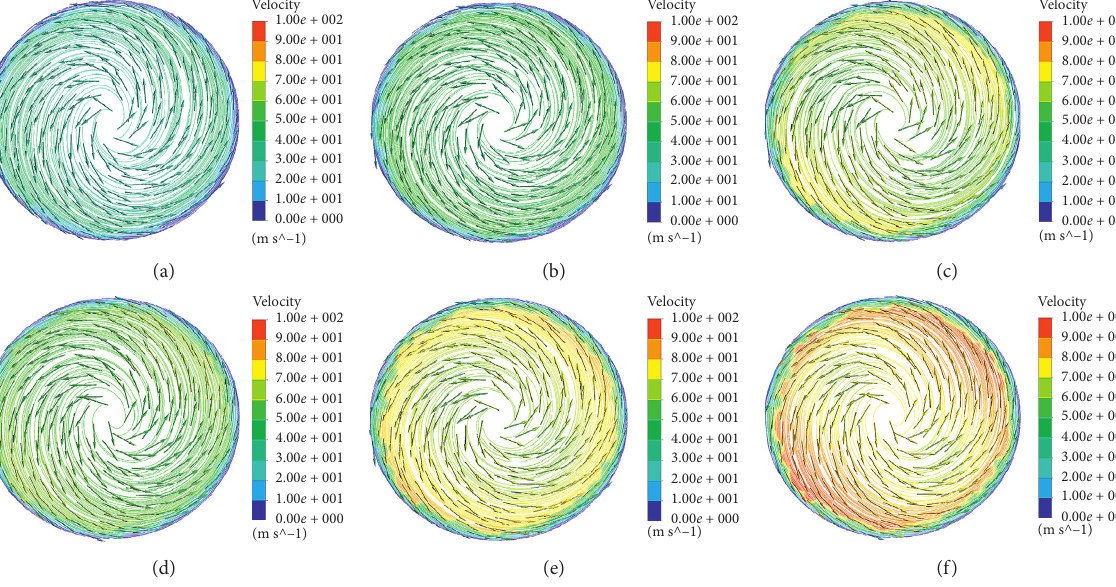
Figure 6: Streamline distribution in the center section of swirl outlet: (a) 1MPa, (b) 2MPa, (c) 3MPa, (d) 4MPa, (e) 5MPa, and (f) 6MPa. 1. Water supply tank